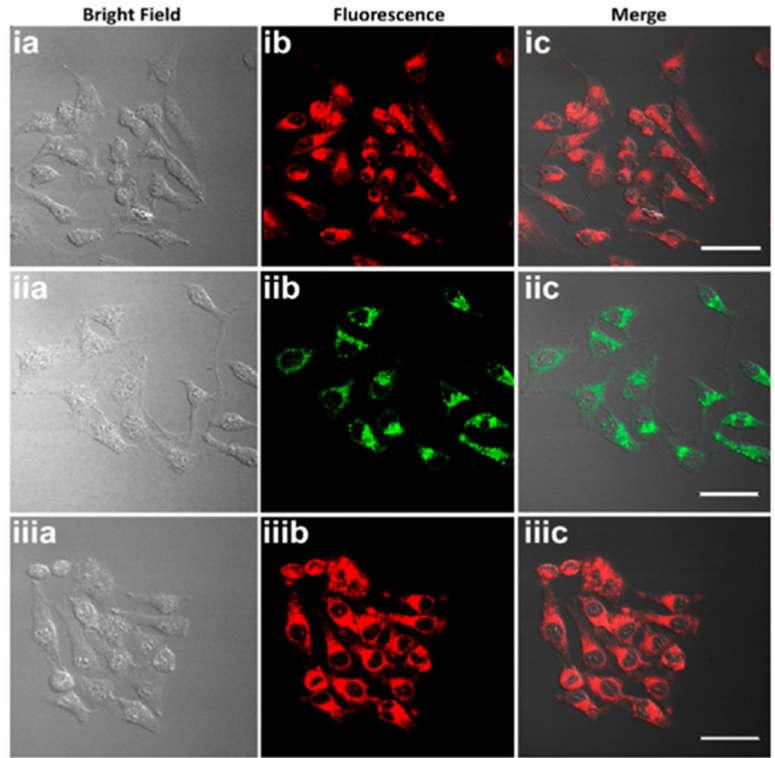
Figure 20. ( a ) Bright-field, ( b ) fluorescence, and ( c ) merged images of HeLa cells incubated with ( i ) probe 8 NPs in water, ( ii ) MM-8@ Plu127 , and ( iii ) EM-8@Plu127 , scale bar: 50 µ m. Emission was recorded using 550 nm channel for the green emission and 700 nm channel for the NIR emission [63].